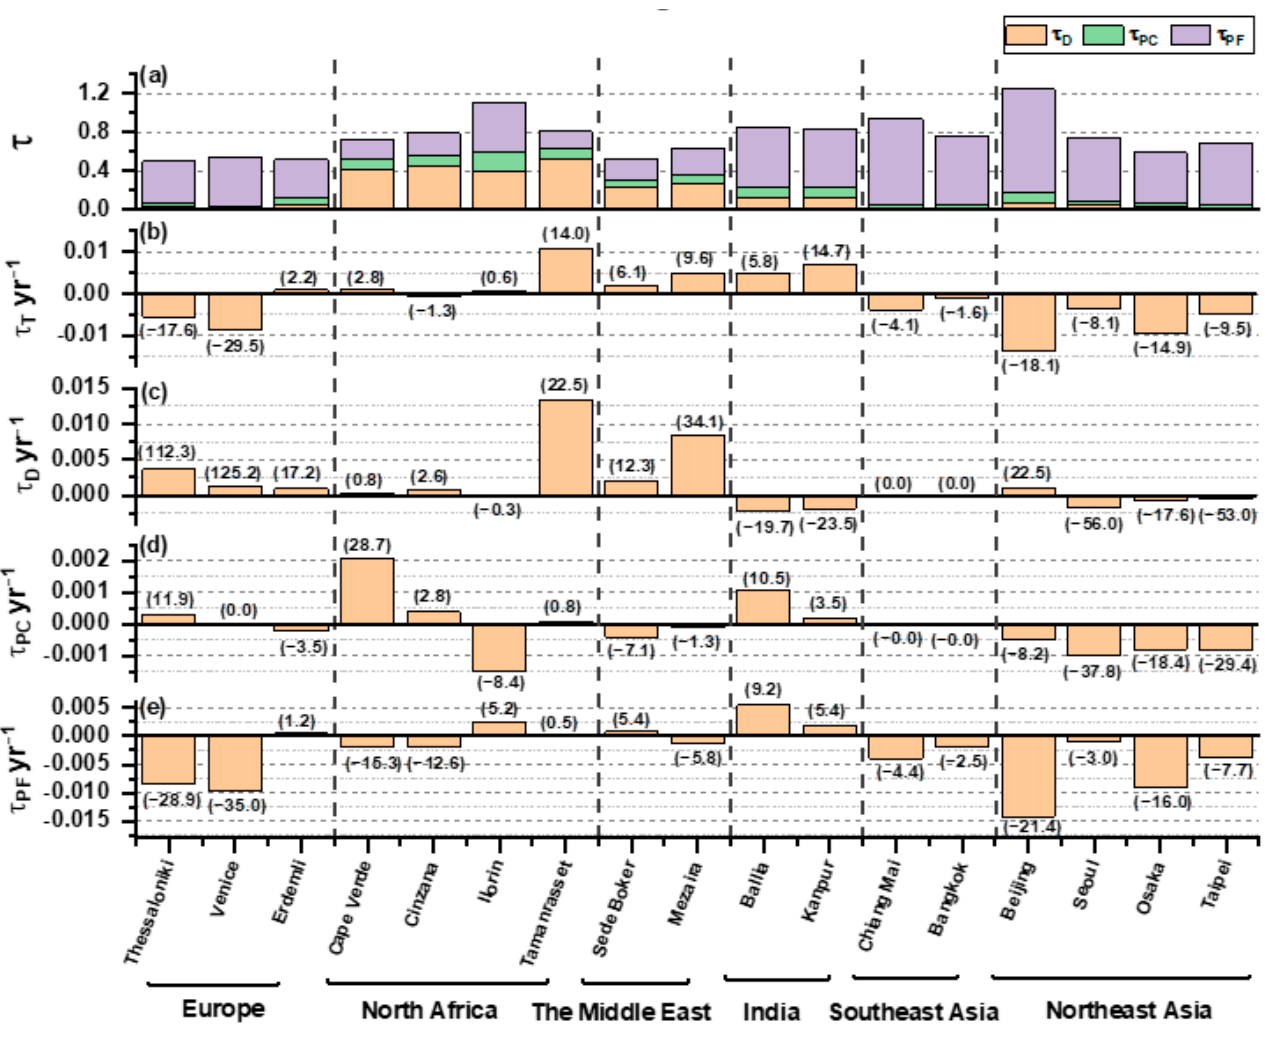
Figure 3. ( a ) Average AOD in terms of dust and coarse- and fine-mode pollution AOD, and the change of annual values of ( b ) total AOD ( τ T ), ( c ) dust-only AOD ( τ D ), ( d ) coarse-mode pollution AOD ( τ PC ), and ( e ) fine-mode pollution AOD ( τ PF ). The values inside the brackets present the percent variation for each of the 17 sites.